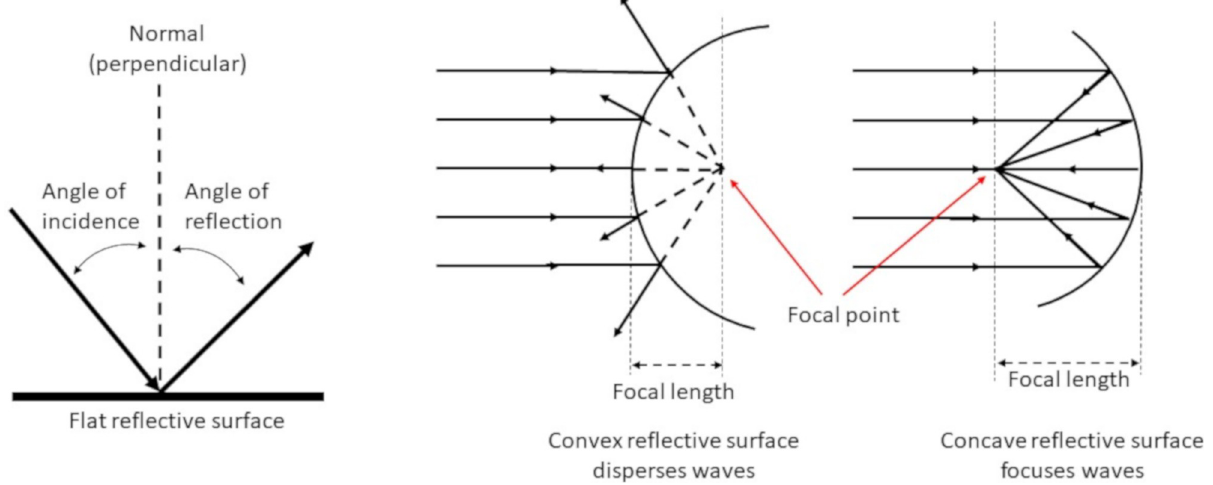
Fig 1. Sound waves have predictable behaviors when they encounter flat, convex, or concave reflective surfaces. The angle of incidence equals the angle of deflection [8].